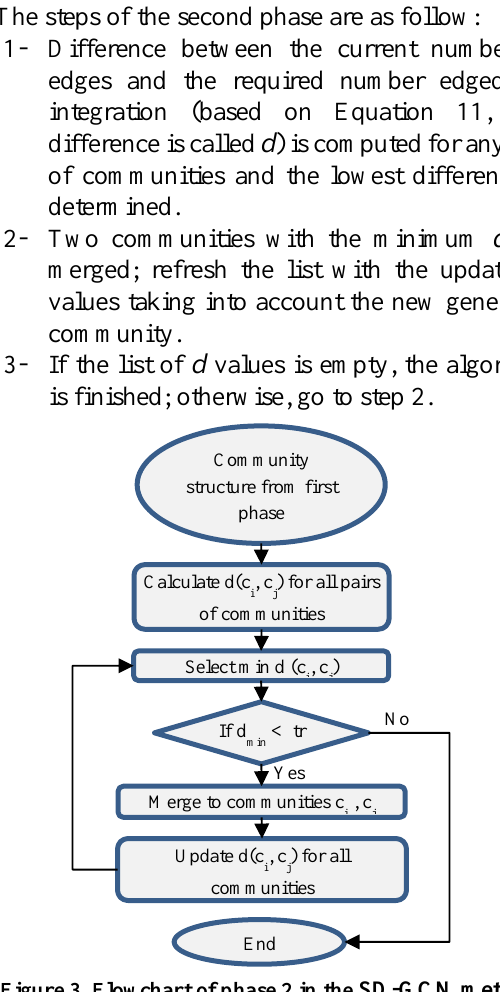
Figure 3. Flowchart of phase 2 in the SD-GCN method .